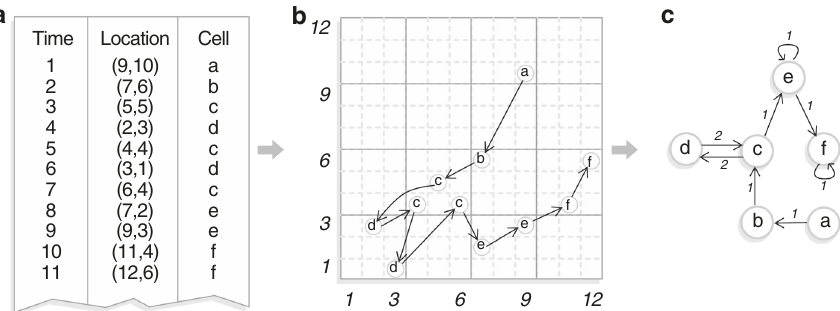
Fig. 8 Chronnet construction method. a Given a time-ordered spatiotemporal data set, the fi rst step consists of dividing the area of study into grid cells. b Shows a spatial representation of the data set using links between cells to indicate the temporal order they occur, in a sliding window of h = 1. c In a chronnet, nodes represent grid cells and links stand for co-occurred events between cells. Link weights indicate the number of consecutive events observed between